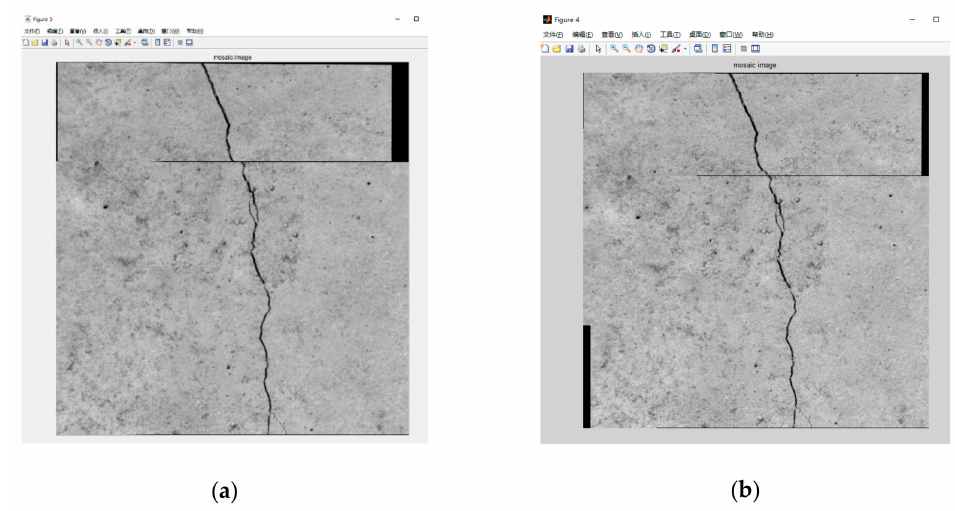
Figure 14. Stitching results: ( a ) left figure and ( b ) right